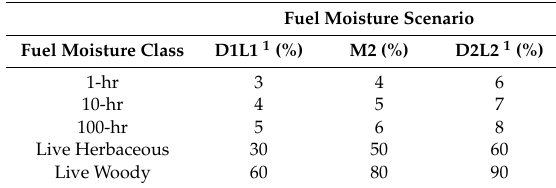
Table A2. The three fuel moisture scenarios used to test the simulated fire behavior of the four custom fuel models. See text for detailed descriptions of each fuel moisture